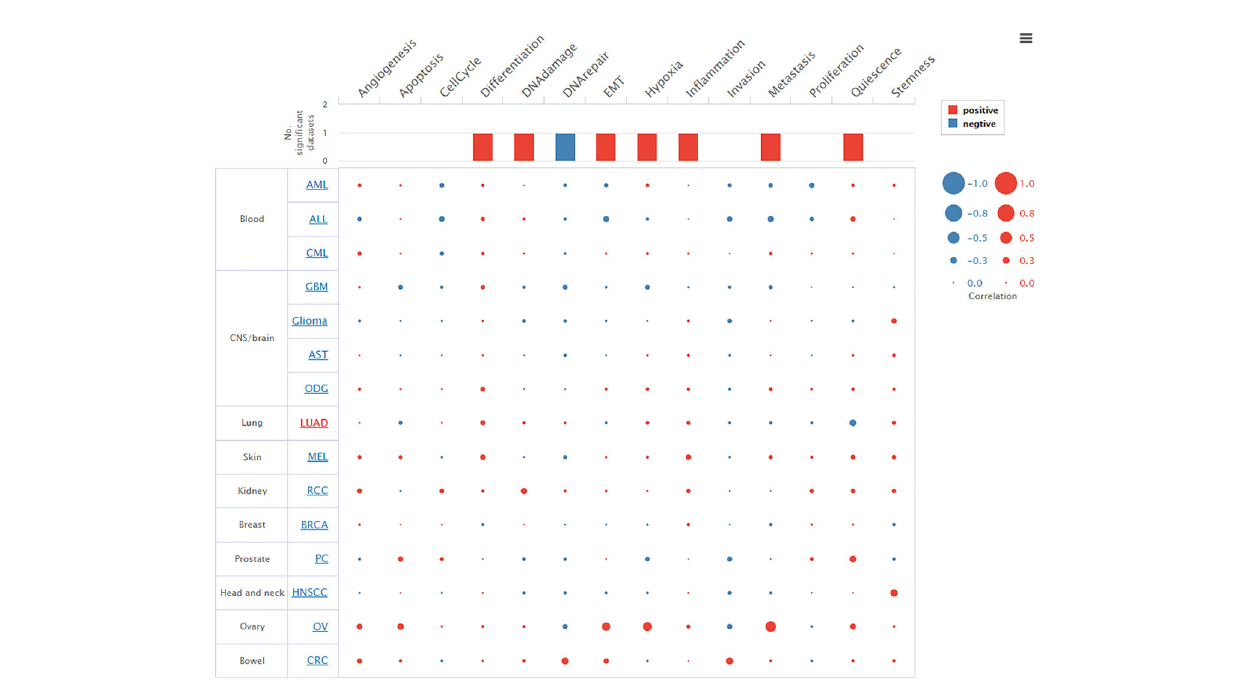
FIGURE 5 | Relevance of TTN across 14 functional states in distinct cancers. Average correlations between TTN and functional states in different cancers. The bar chart showed the number of datasets in which TTN was signi fi cantly related to the corresponding state. The red plots indicated that TTN was positively correlated with the functional state while the blue plots indicated that TTN was negatively correlated with the functional state.